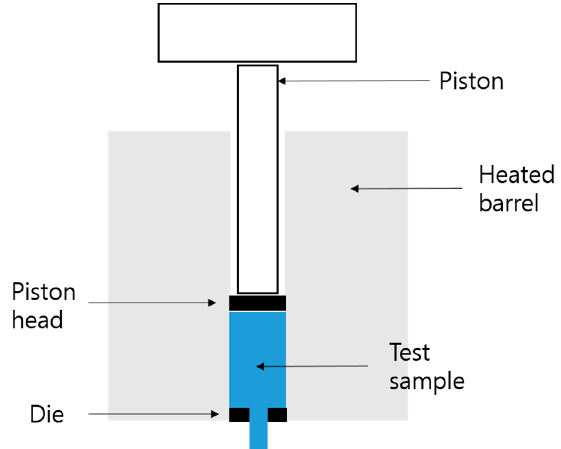
Figure 4. Experimental setup for measuring the MI.